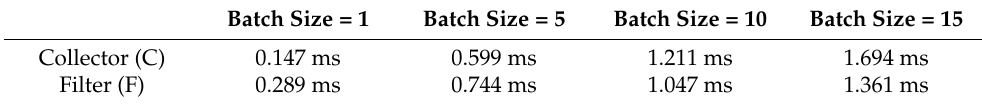
Table 5. Time consumption of collector and filter with different batch sizes.